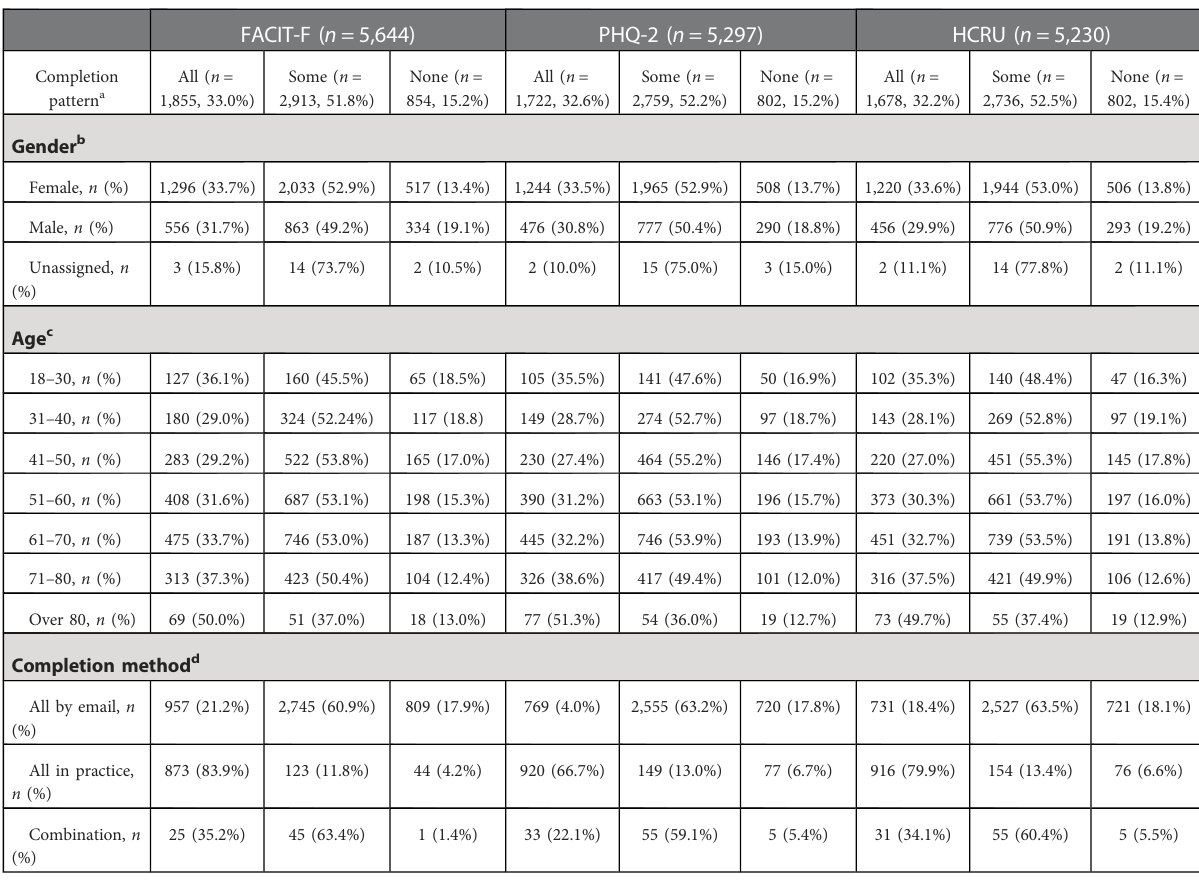
TABLE 3 Longitudinal completion pattern for patients in each PRO